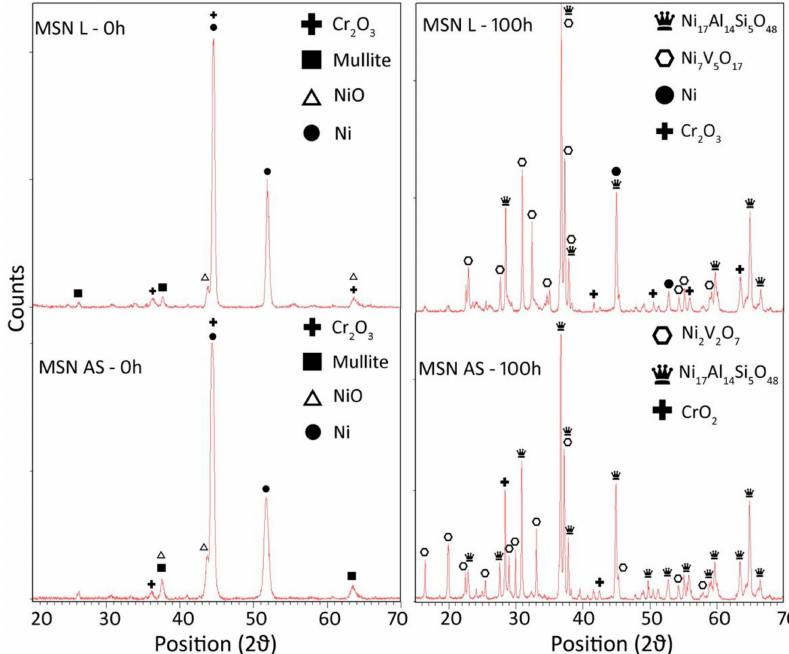
Figure 10. XRD patterns for the MSN samples: AS—as-sprayed (lower left); L—laser-treated (upper left); AS-100 h—as-sprayed, exposed for 100 h (lower right); L-100h—laser-treated, exposed for 100 h (upper